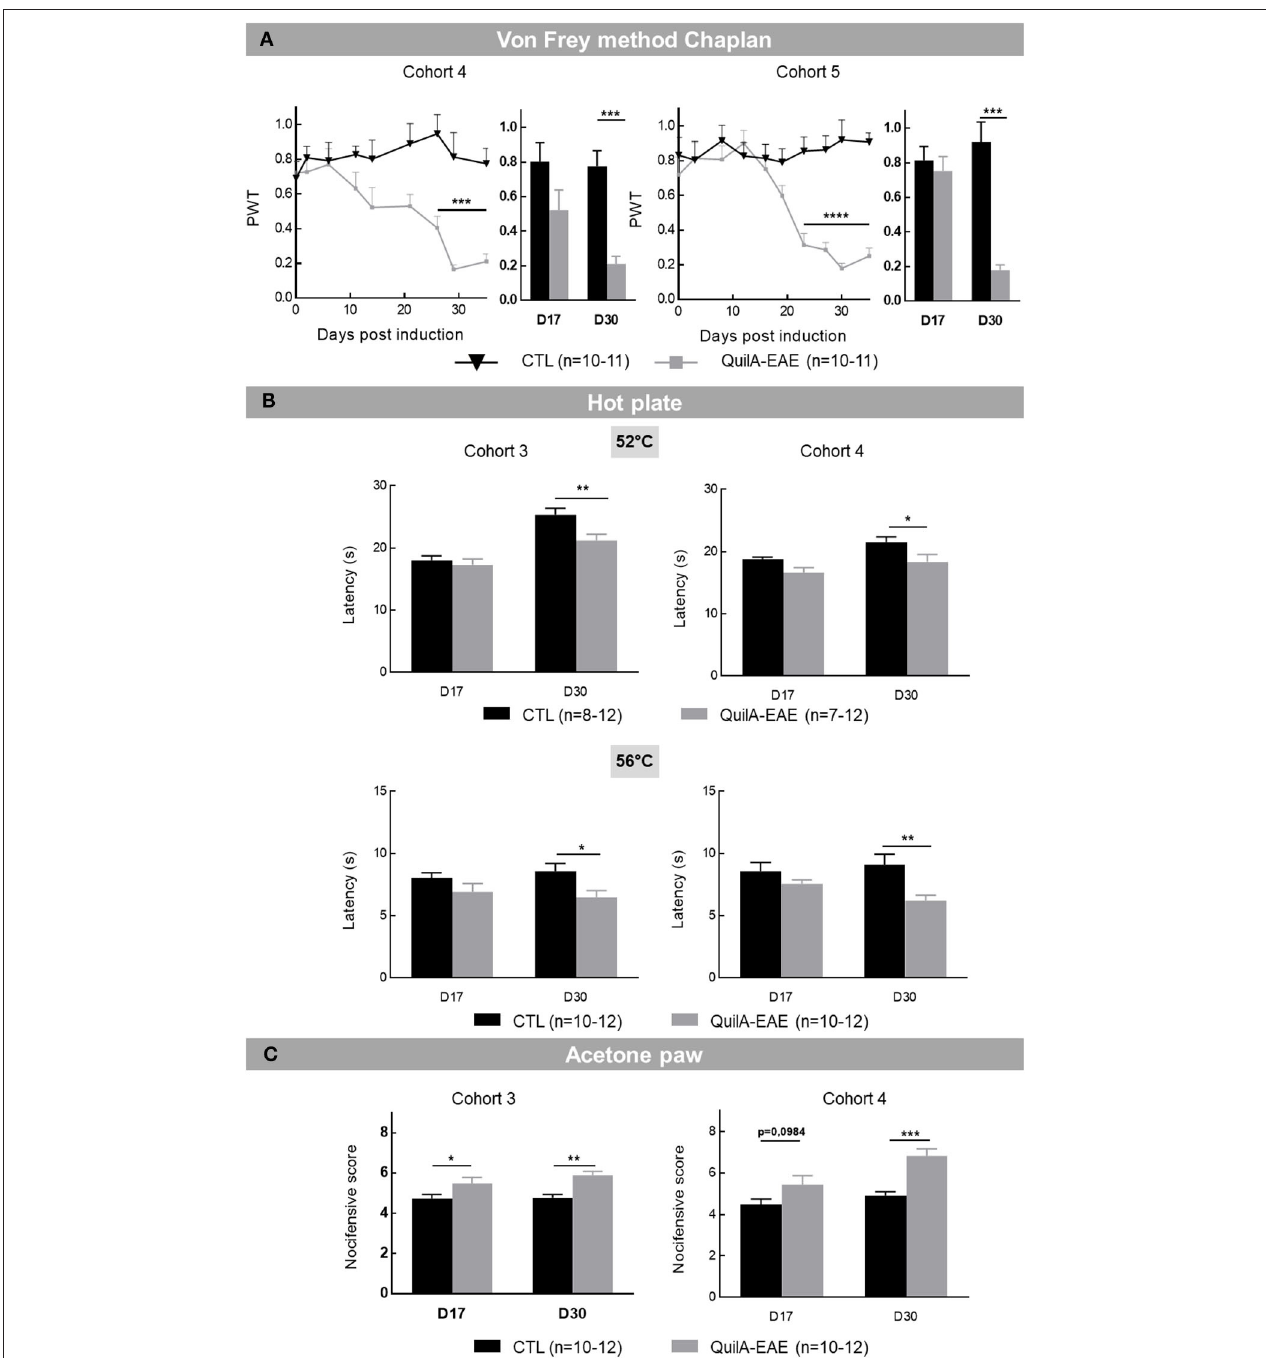
FIGURE 3 | Evaluation of somatic sensitivity in mice immunized with MOG 35 − 55 (QuilA-EAE) and their controls (CTL) at post-induction Day 17 (D17) and D30. (A) Mechanical sensitivity from post-induction Day 0 (D0) to D35. Mechanical sensitivity expressed as the mean of paw withdrawal threshold (PWT) ± SEM for each time point. Data are illustrated using time course curves and bar chart showing results obtained at D17 and D30. (B) Heat hyperalgesia at D17 and D30 expressed as the mean time taken to observe a nocifensive behavior in mice exposed to a hotplate ± SEM with hotplate at 52 ◦ C (top) and 56 ◦ C (bottom). (C) Cold allodynia at D17 and D30 was expressed as the mean number of nociceptive responses ± SEM observed in mice after acetone drop deposition. Statistical analysis was performed using two-way ANOVA followed by post-hoc Sidak test; * p < 0.05, ** p < 0.01, *** p < 0.001 vs. control (shown for Sidak test only).